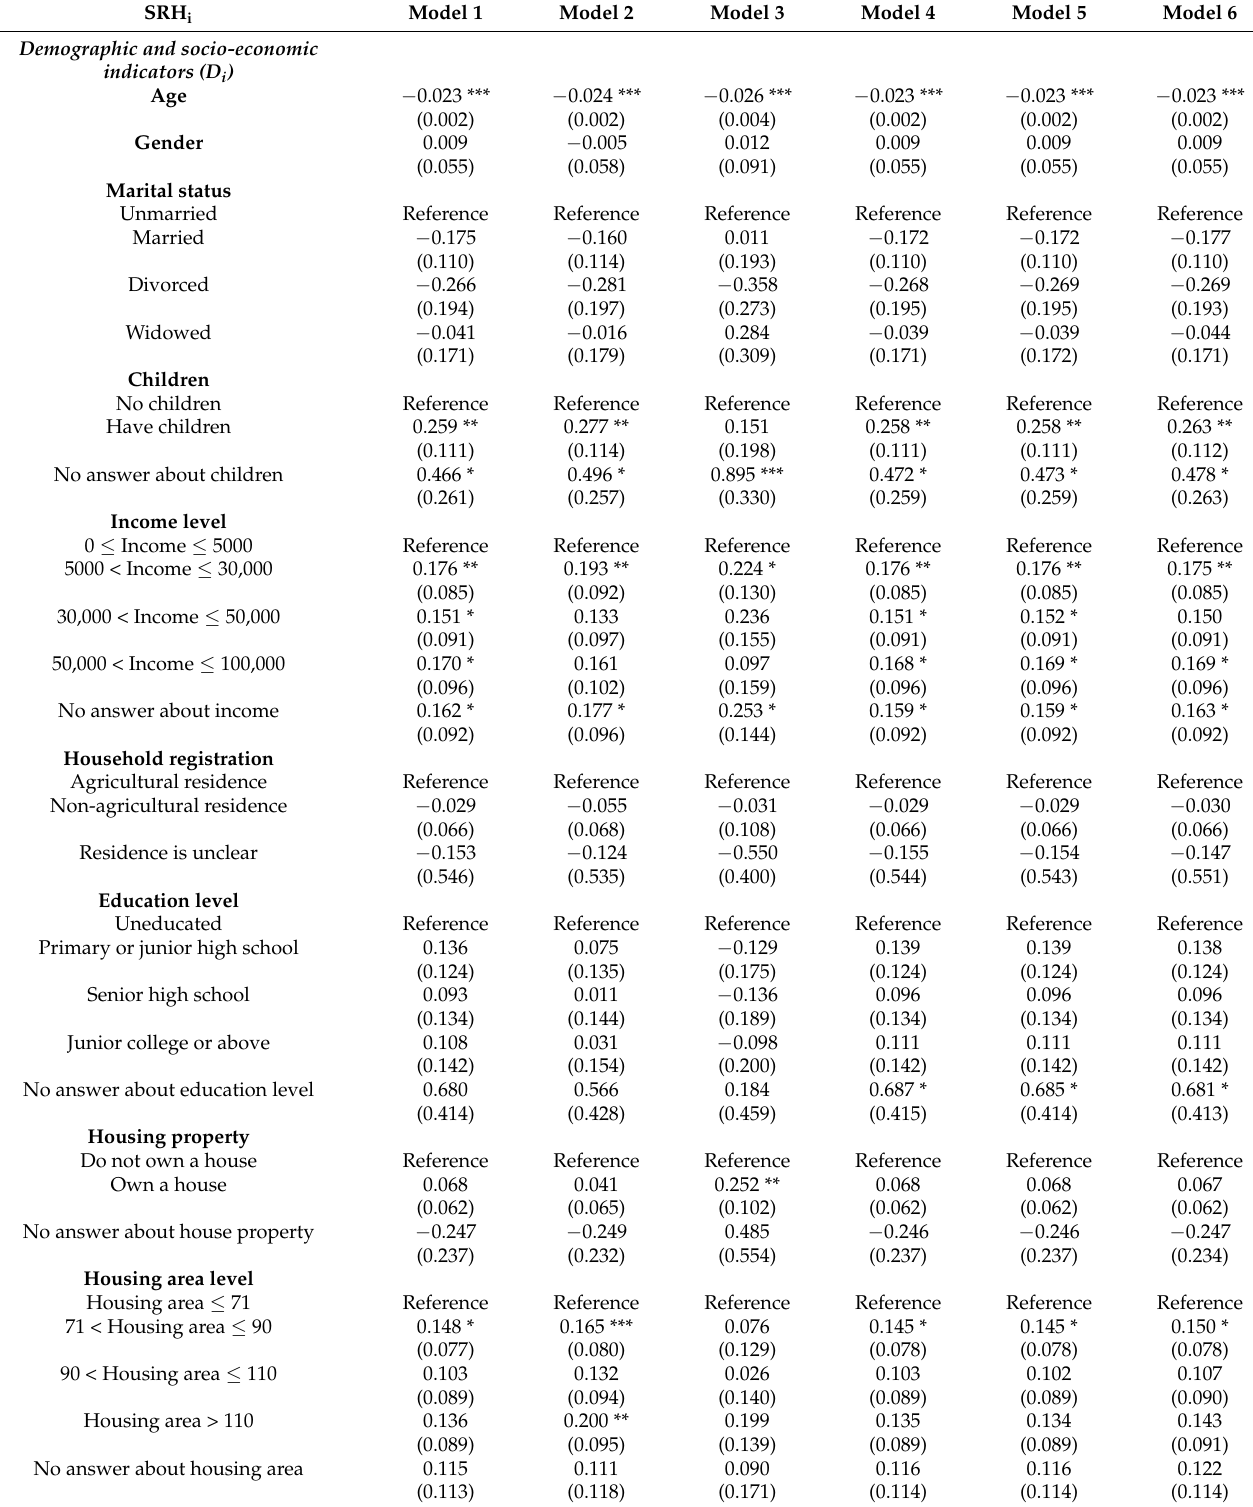
Table 2. Results of the regressions of all